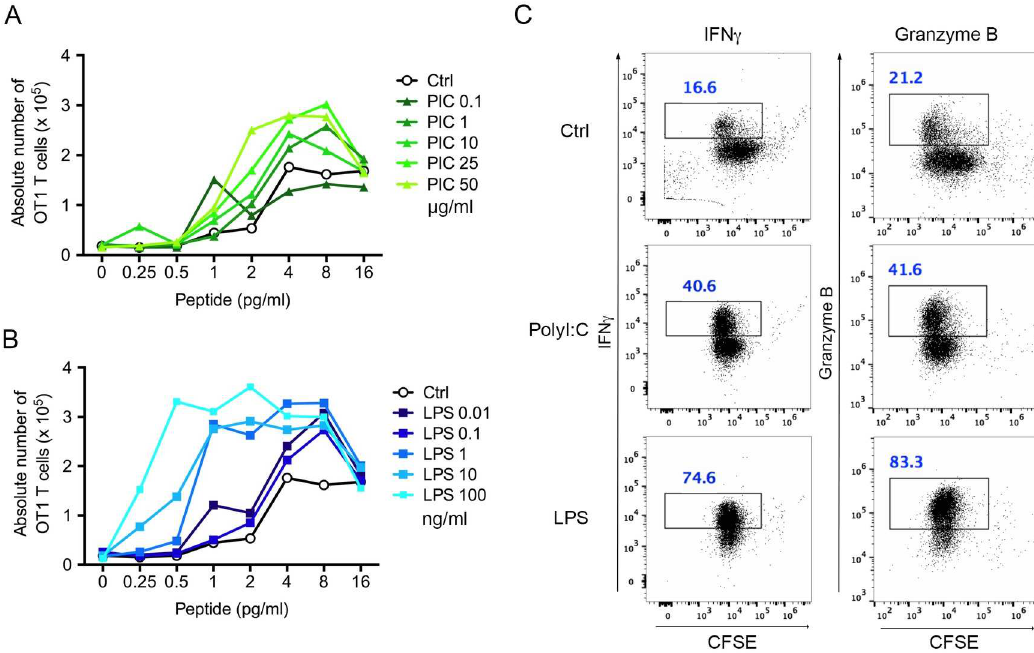
Fig 2. PolyI:C pre-treatment impedes the capacity of DCs to elicit an antigen-specific cytotoxic T cell response. ( A-B ) DCs were either left non-treated(Ctrl) or treated with different concentrations of polyI:C or LPS as indicatedfor 20 h, washed, loadedwith different doses of SIINFEKL peptideand incubatedwith CFSE-labelledOT1 CD8 + T cells at a 1:1 ratio. Three days later, the numberof total CFSE-high and low positive T cells were enumeratedby FACS-based cell counting.Data are presentedas an absolutenumberof OT1 T cells present in each well. ( C ) OT1 T cells co-cultured for 3 days with polyI:C (25 μ g/mL) or LPS (10 ng/ml) pre-treatedDCs loadedwith 4 pg/mL of SIINFEKL peptidewere permeabilizedand stained for IFN γ and Granzyme B. Numbers in the windows indicate the percentageof positive cells amongtotal T cells in the well. The figures are representative of 2 independentexperiments.